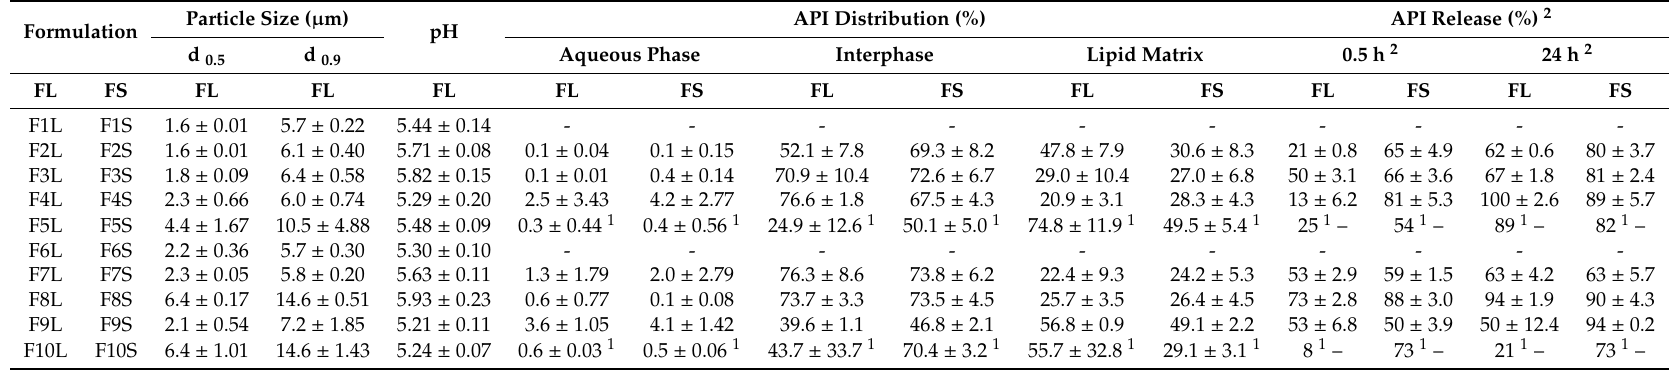
Table 2. Characteristics of the investigated solid lipid microparticle (SLM) dispersions prepared “de novo” (FL—liquid formulations) and reconstituted (FS—spray-dried formulations). API: active pharmaceutical ingredient, d 0.5 and d 0.9 : the particle size at which the cumulative particle size distribution curve reaches 50% and 90% of the volume,